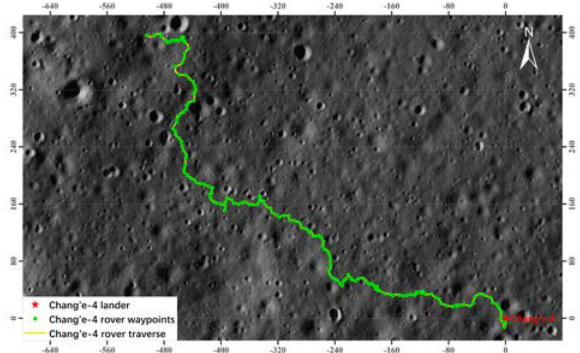
Figure 3. Traverse map of Yutu-2 rover as of 9 March 2022 (Unit: m).